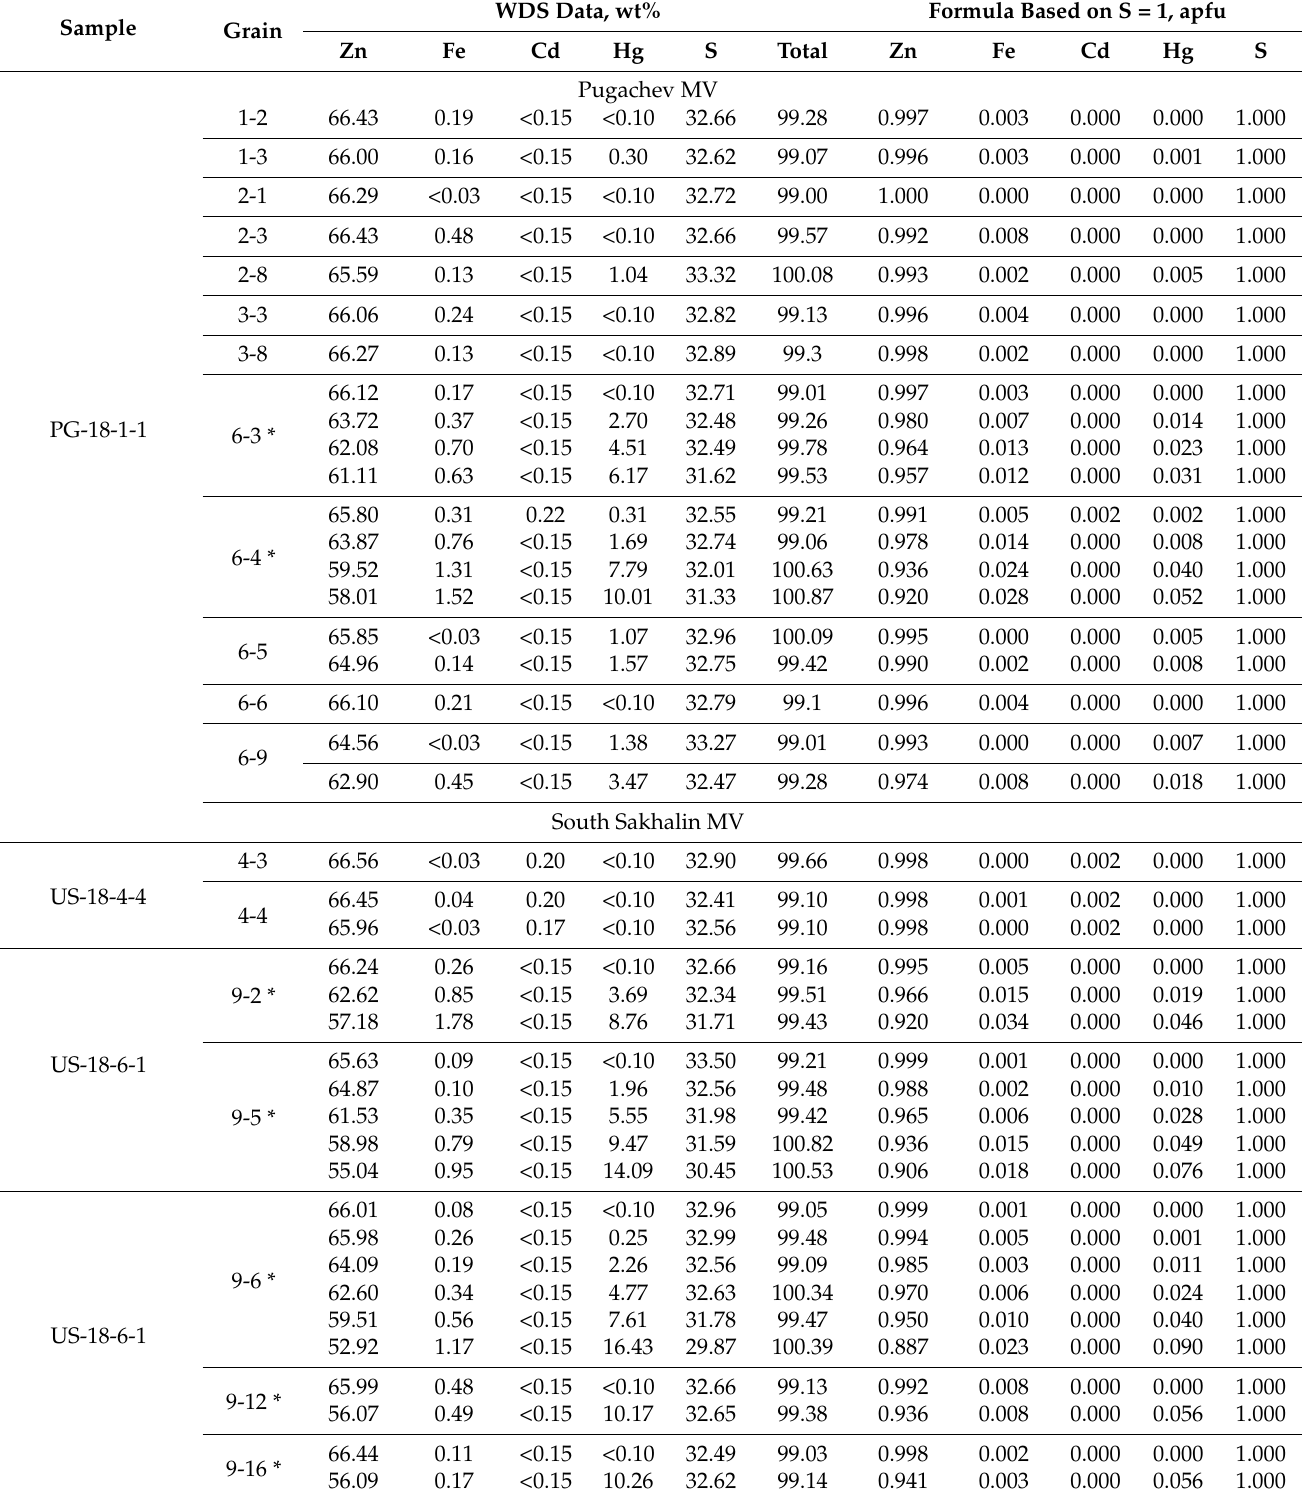
Table 4. Representative compositions (WDS) of sphalerite from mud masses of Pugachev and South Sakhalin MVs.